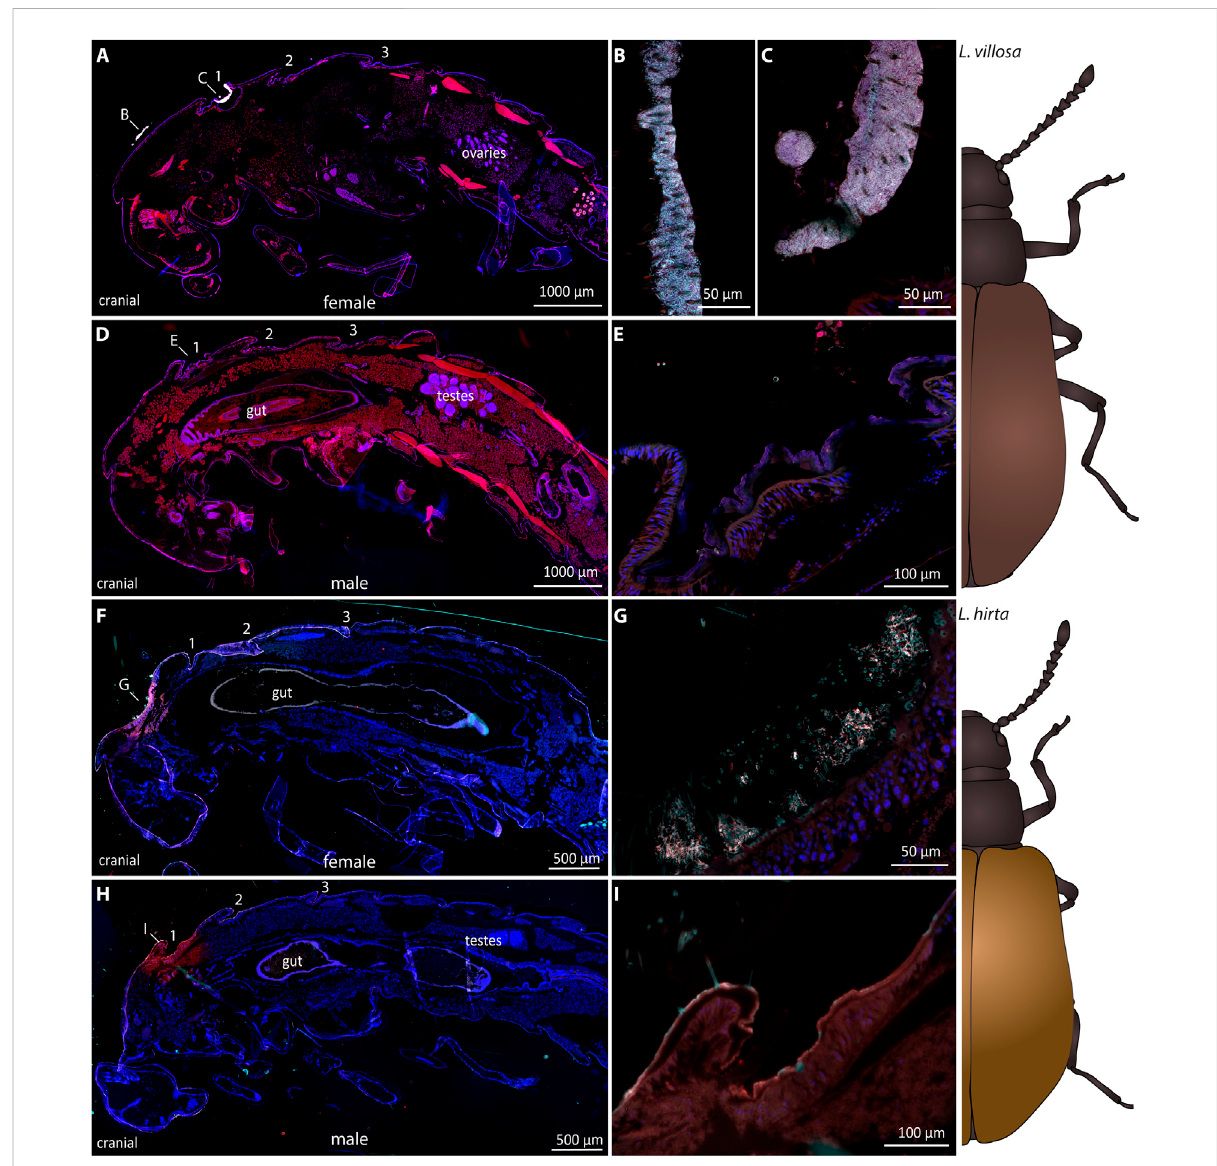
FIGURE 2 Sexual dimorphism of symbiotic organs and symbiont localization in Lagria pupae using FISH. FISH was carried out on semithin sagittal histological sections of L. villosa (A – E) and L. hirta (F – I) pupae. Symbiont cells are generally depicted in white, host cell nuclei in blue, and auto fl uorescence of the host tissue in red. (A – E) Symbionts were present in female L. villosa pupae (A) on the surface of the thorax between bristles (B) and within the fi rstdorsalsymbiontorgan (C) ,while symbionts werenot detectable inmale pupae (D,E) . (F – I) Symbiontsweredetected in L. hirta females (F) inapitofthedorsalthoraxbetweenbristles (G) whiletheywerenotdetectableinmales (H,I) . Burkholderia-speci fi c stainingisshown in cyan, general eubacterial staining in red, and host cell nuclei in blue (DAPI). Overlapping signal is shown in white. Numbers indicate the location of symbiotic organs or cuticular structures in the respective position and all images show sagittal sections with the cranial end to the